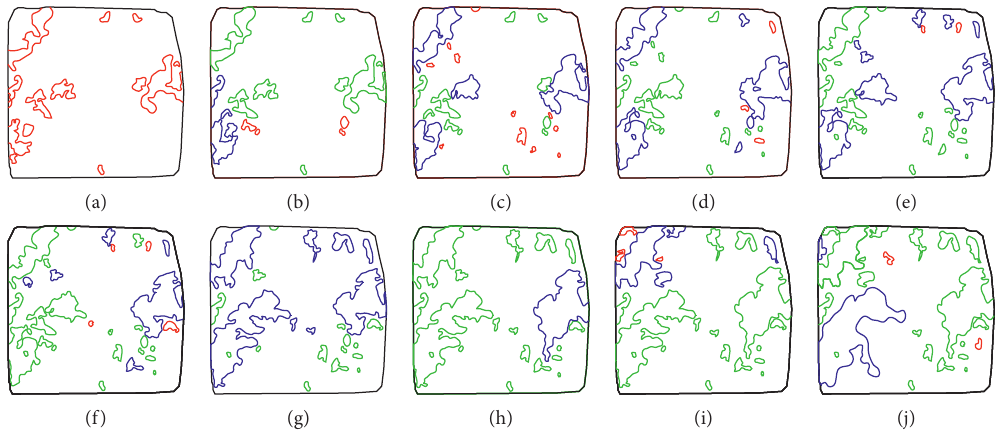
Figure 6: Variation of wear zones on the surface of the Sandstone Joint with cycles.